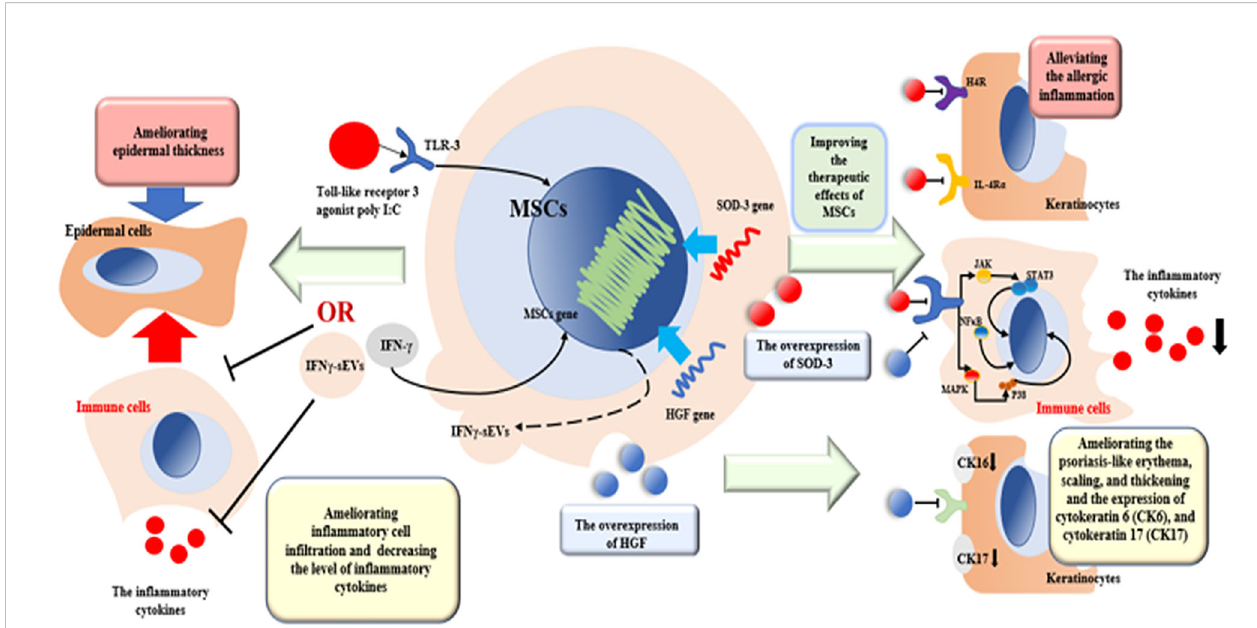
FIGURE 2 The potential mechanism of preconditioned MSCs and EVs in treating AD and psoriasis. SOD3-transduced MSCs can alleviate the allergic in fl ammation in keratinocytes through competitively interacting with H4R and IL-4R a . SOD-MSCs can reduce the in fl ammation in the skin through the NF k B, MAPK, and JAK-STAT pathways. HGF-transduced MSCs can ameliorate psoriasis-like erythema, scaling, and thickening and the expression of CK6 and CK17 and decrease pro-in fl ammatory cytokines such as IFN- g , IL-6, and TNF- a . Preconditioned with the TLR3 agonist poly I:C or IFN- g can ameliorate more epidermal thickness and in fl ammatory cell in fi ltration in skin lesions. IFN g -sEVs can decrease pro-in fl ammatory cytokines including IL-17A, IFN- g , IL-6, and TNF- a and Th17 cells and increase the population of